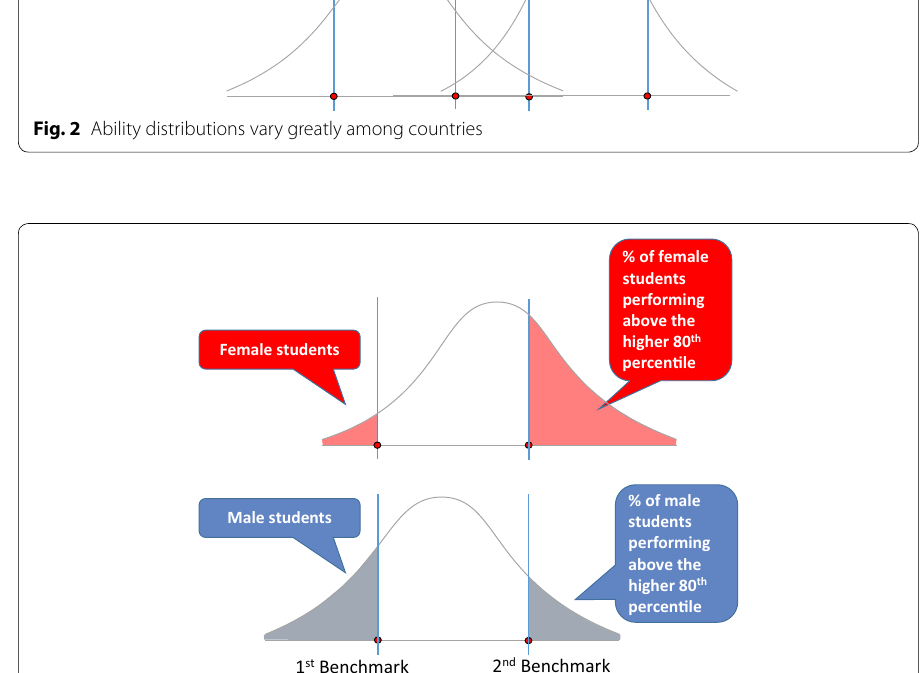
Fig. 3 Estimating relative distributions of female and male students in the groups of ‘high’ and ‘low’